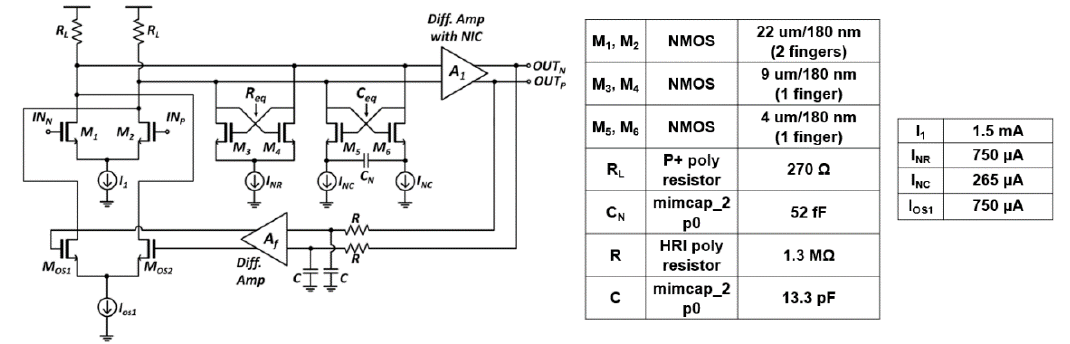
Figure 6. Schematic diagram of the LA with negative impedance compensation.